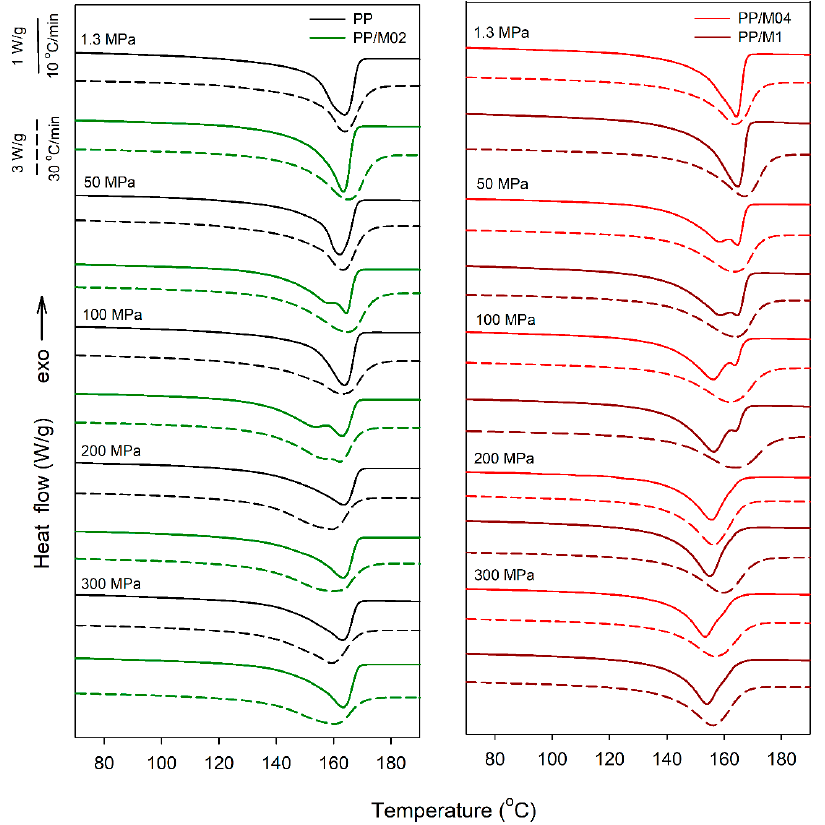
Figure 9. DSC heating thermograms recorded at rates of 10 °C/min (solid lines) and 30 °C/min (dashed lines) for neat and nucleated PP crystallized during cooling under elevated pressure according to protocol I.